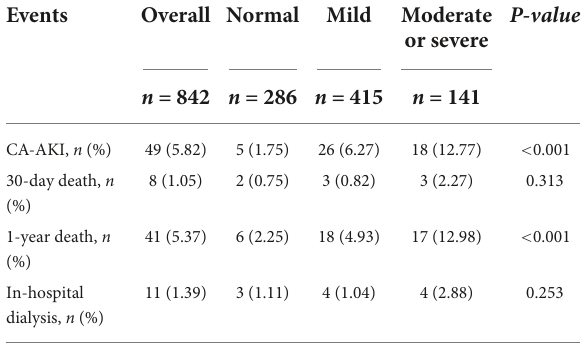
TABLE 2 CA-AKI incidence and clinical outcomes.